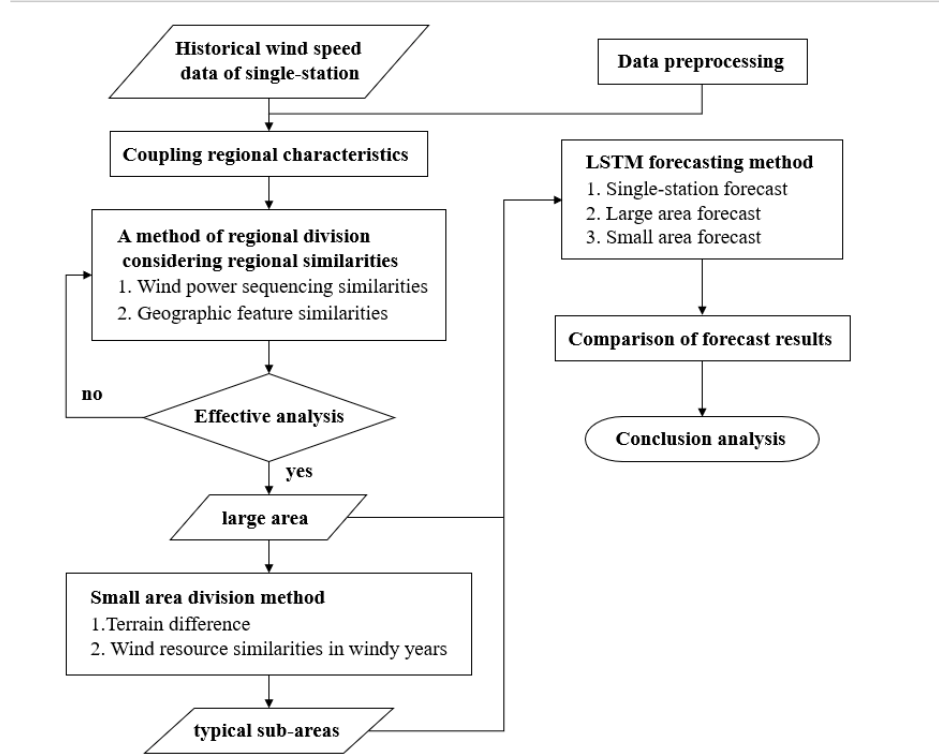
Figure 1. A flowchart of the proposed method.